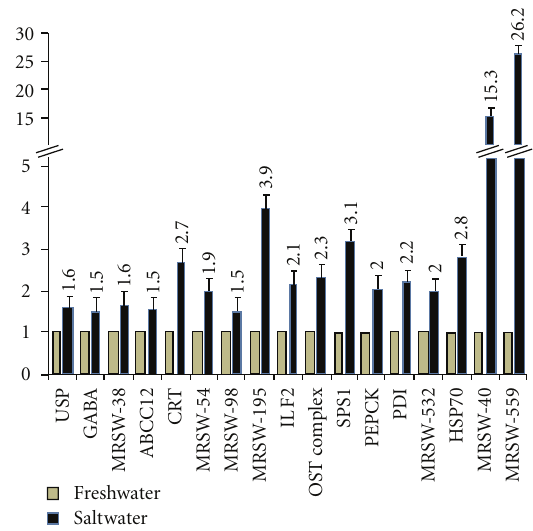
Figure 2: The expression profiles of selected ESTs enriched from SSH cDNA library by quantitative real-time polymerase chain reaction (qPCR). The qPCR data for all ESTs was normalized with RPL8 as reference gene. The qPCR data shows the relative gene expression levels in the salt water-stressed gill of M. rosenbergii over unstressed gill (default setting as 1 in each case). The clones MRSW-40 and MRSW-559 were significantly up-regulated in the tune of about 15- and 26-fold, respectively. The rest of the clones were up-regulated in the tune of ≥ 1.5-fold. The numbers on top of each bar for salt water-treated gill represent fold changes in expressions relative to the expressions in freshwater-treated gill. The data represents the average of three independent (each in duplicate) experiments. USP, ubiquitin-specific protease; GABA, γ -aminobutyric acid; ABCC12, ATP-binding cassette protein C12; CRT, calreticulin; ILF2, interleukin enhancer binding factor 2; OST complex, oligosaccharyltransferase complex; SPS1, selenophos- phate synthetase 1; PEPCK, phosphoenolpyruvate carboxykinase; PDI, protein disulphide isomerase; HSP70, heat shock protein